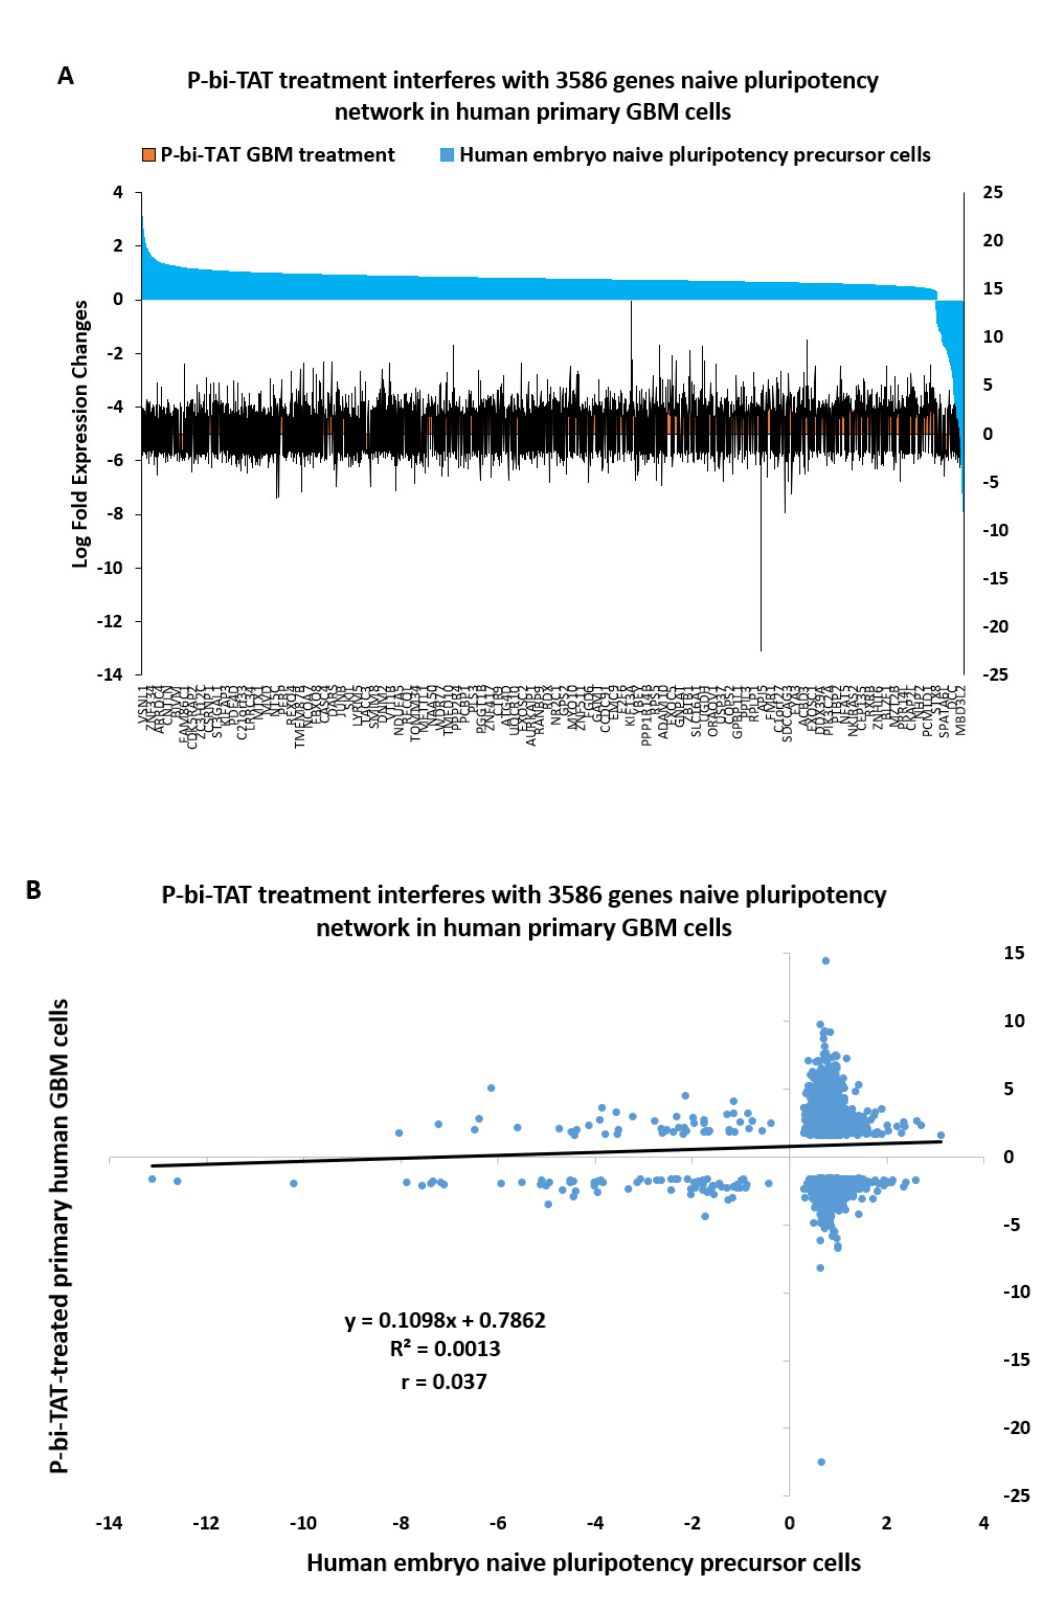
Figure 7. Treatment of human GBM cells with the P-bi-TAT thyrointegrin antagonist exerts disorderly effects on expression of 3586 genes of naïve pluripotency networks operating in malignant cells. The disorderly effects of the P-bi-TAT on stemness pathways’ gene expression are documented by analyses of gene expression profiles ( A ) and correlation patterns ( B ). See Text and Supplemental Table S3 for details.